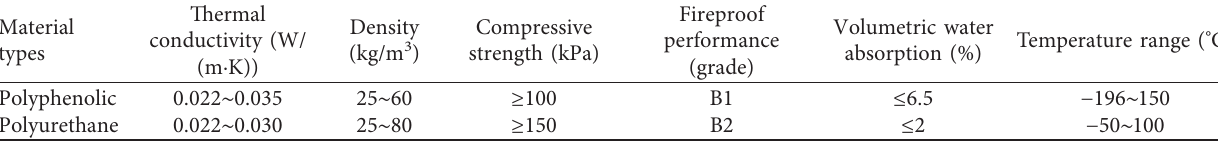
Table 1: Basic performance indicators of insulation materials.